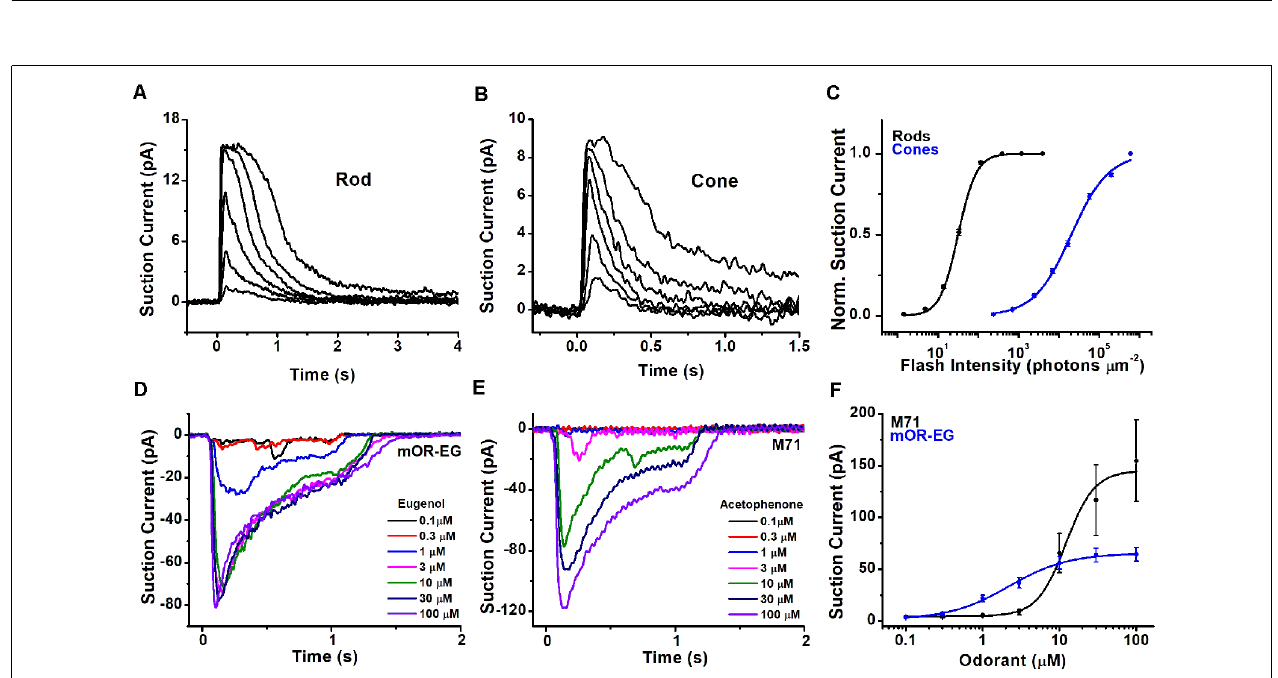
FIGURE 3 | Light and odorant-induced responses. Typical response families from single-cell suction current recordings obtained from a mouse rod (A) and cone (B) . 10 ms flashes of various intensities were delivered to each photoreceptor at time 0, with each successive flash 0.5-log times brighter than the previous one. (C) Normalized intensity-response functions showing that cones have approximately 2.5 log units lower sensitivity in comparison to rods. Suction current recordings from OSNs expressing the mOR-EG (D) or M71 (E) olfactory receptor, stimulated with increasing concentrations of the odorants eugenol and acetophenone, respectively. (F) Dose-response curves showing different sensitivity of mOR-EG and M71-expressing OSNs. Figures modified from Kefalov et al. (2010), Sakurai et al. (2011), Deng et al. (2013), and Dibattista and Reisert (2016) with